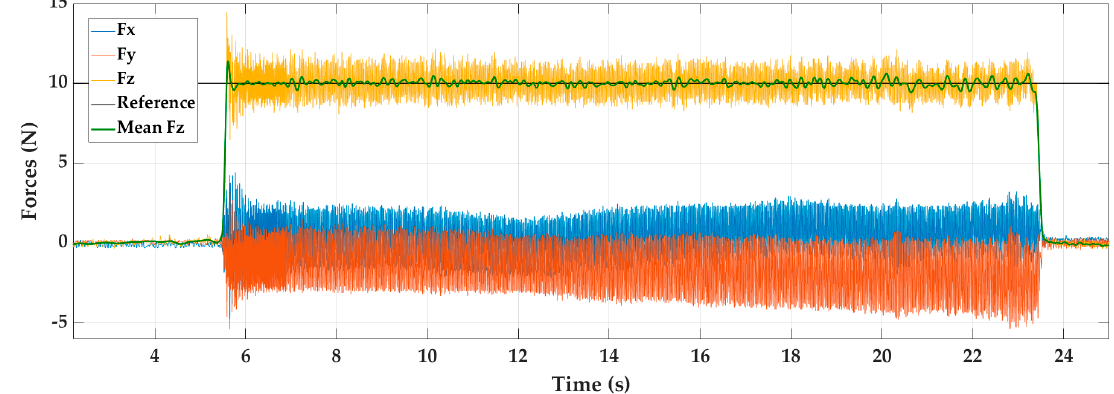
Figure 10. Force response for UR3 sanding wood with a sandpaper grain size of 400.